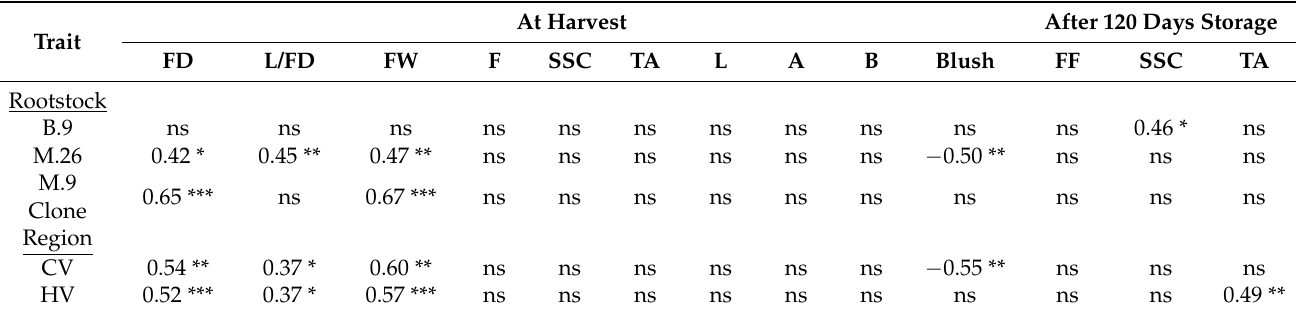
Table 7. Bitter pit multivariate analysis in ‘Honeycrisp’ apples stored at 2.2 ◦ C for 120 days against all fruit dimensions and fruit quality traits for each rootstock category over three years of study (2016–2018).